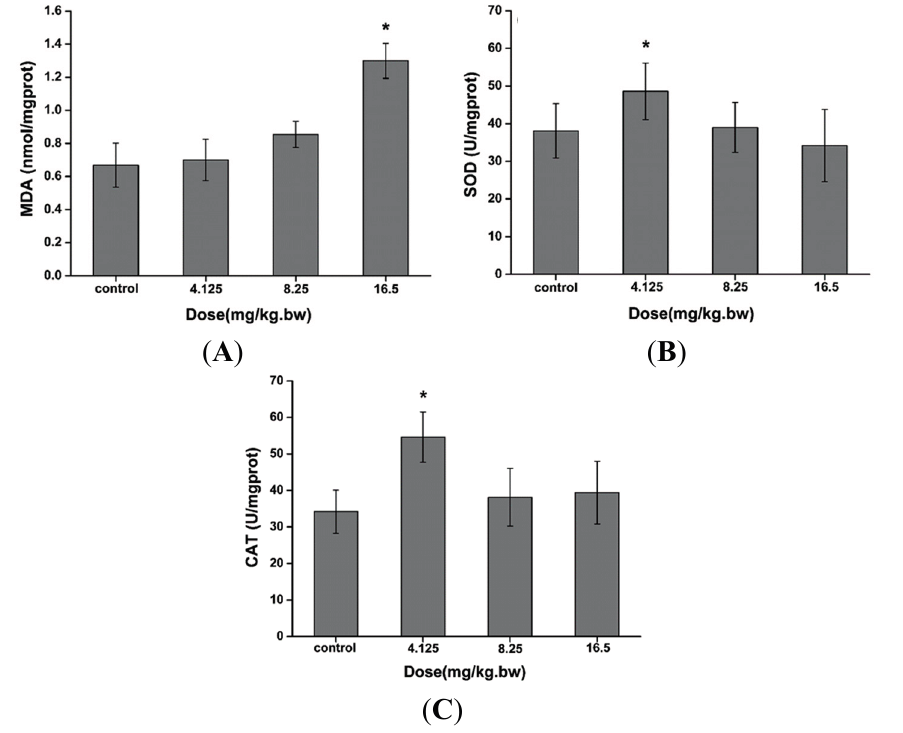
Figure 2. The ( A ) malondialdehyde (MDA) levels; ( B ) superoxide dismutase (SOD) and ( C ) catalase (CAT) activities in the liver after an intratracheal administration with 4.125–16.5 mg/kg.bw CdTe QDs. The asterisks ( * ) indicate statistically significant differences compared to the control with p < 0.05.